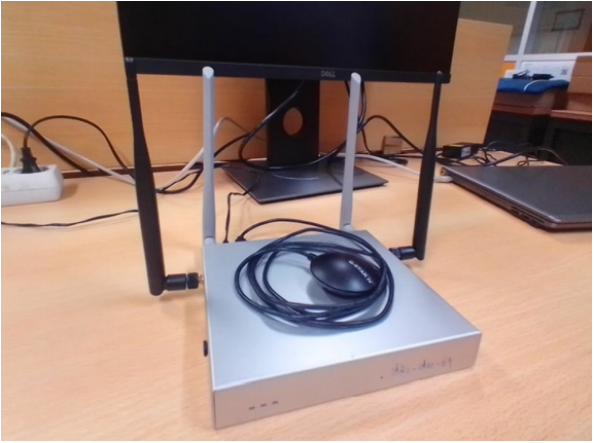
Figure 2. OBU with GPS